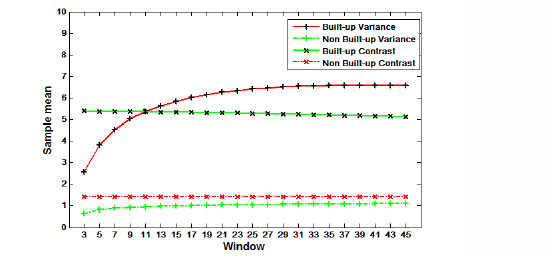
Fig. 4 Relationship between sample mean and window size